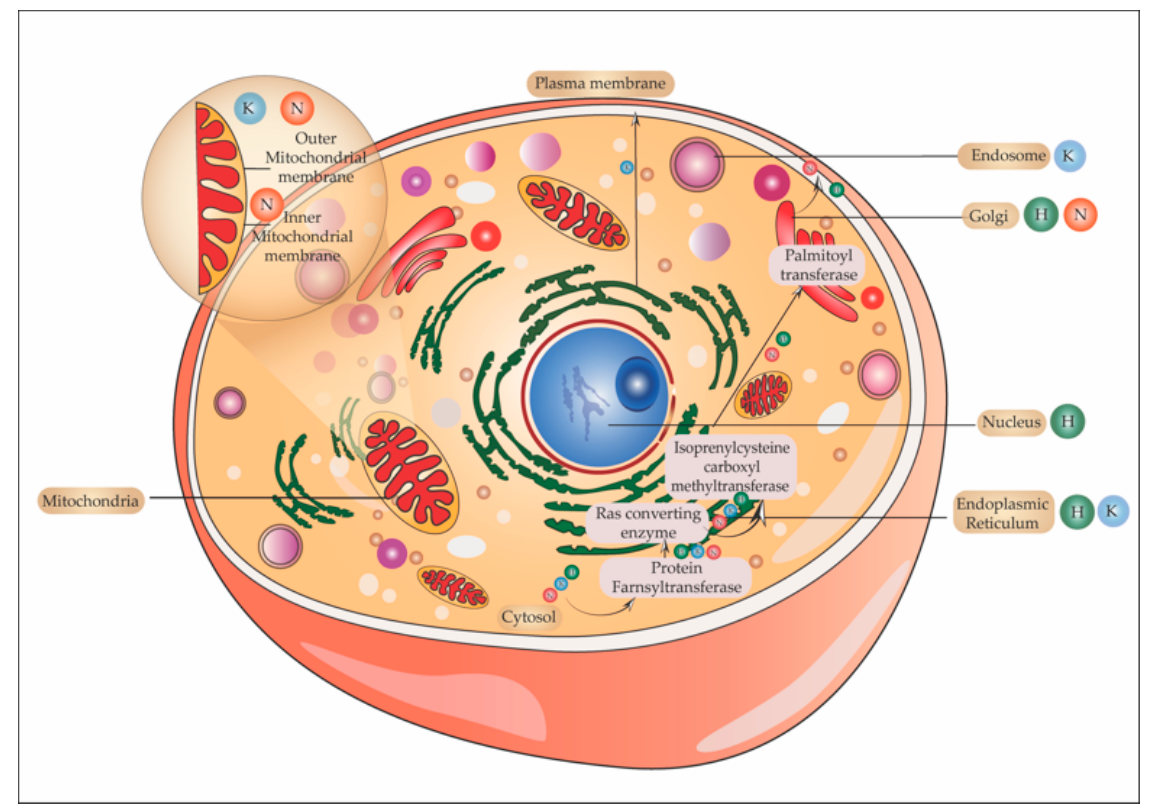
Figure 6. Ras isoforms are distributed and signals from not only the plasma membrane but also from other signaling platforms like Golgi, endoplasmic membrane, mitochondria, endosome, etc. Once produced in the cytosol, Ras undergoes a series of post-translational modifications in the endoplasmic reticulum and Golgi. Ras is farnesylated by protein farnesyl transferase (PFT), further proteolytically cleaved by Ras converting enzyme (RCE), and carboxymethylated by isoprenylcysteine carboxyl methyltransferase (ICMT). H/N-Ras enters the Golgi to be palmitoylated and subsequently targeted to the plasma membrane. while K-Ras goes addition of lysine residues and takes a Golgi-independent route to the plasma membrane. The presence of different Ras isoforms has been detected from the mitochondria, E.R, Golgi, endosome, and the nucleus.